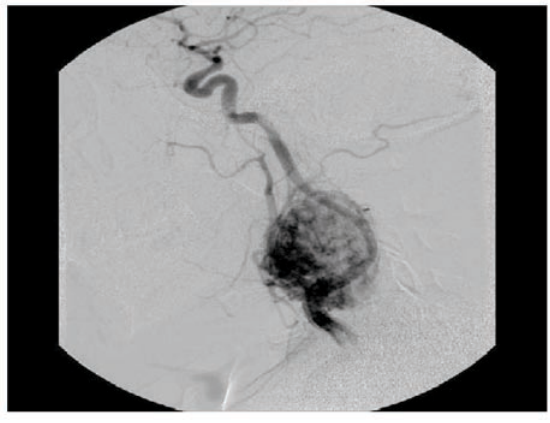
Figure 1. Pre-embolisation.